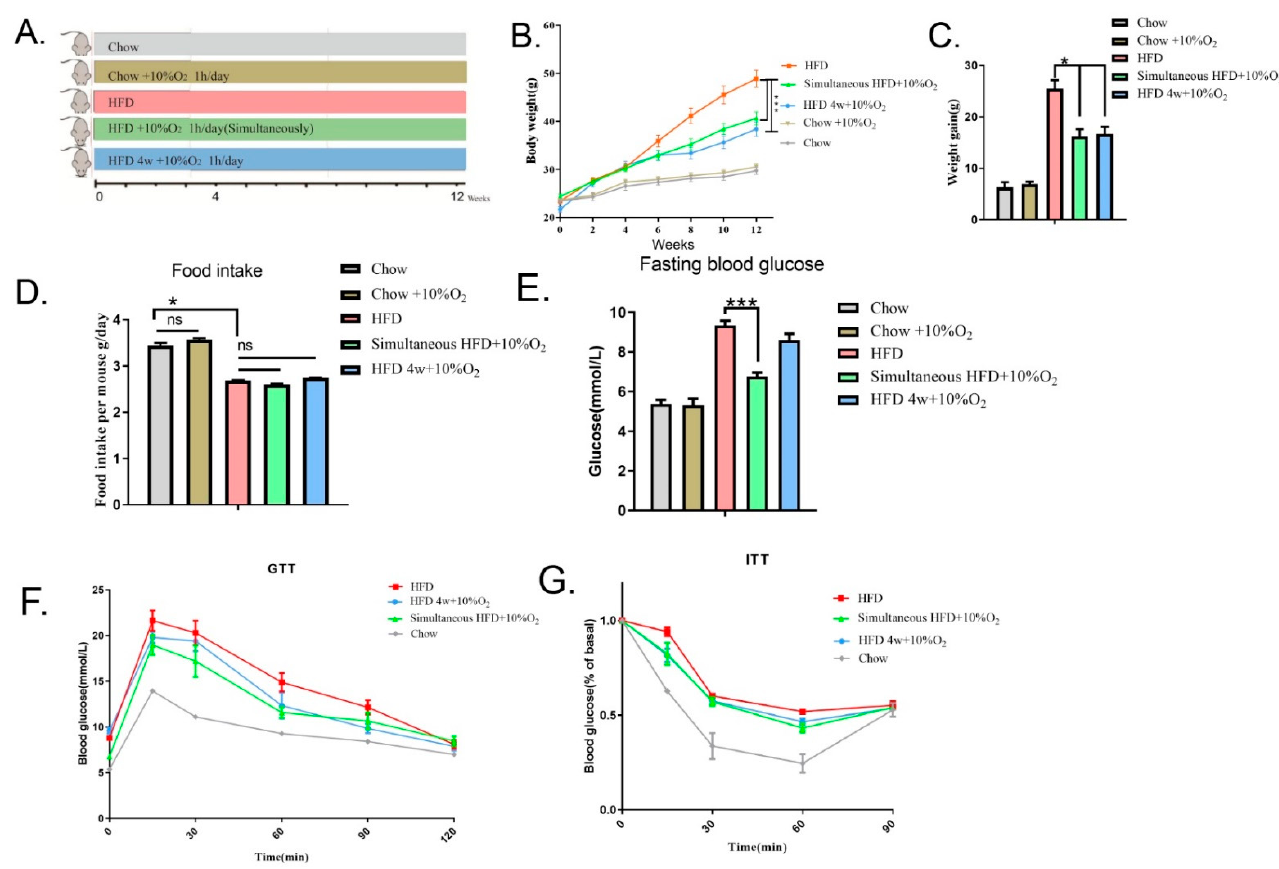
Figure 1. Chronic intermittent hypoxia reduces the bodyweight gain induced by HFD and improves insulin resistance. Experimental mice were exposed to ambient oxygen (normoxia) or 10% oxygen for one hour every day. ( A ) Scheme of grouping (8 mice per group): (1) chow diet and normoxia, (2) chow diet exposed to 10% oxygen, (3) HFD and normoxia, (4) HFD and 10% oxygen simultaneously, (5) HFD for 4 weeks and then 10% oxygen applied. ( B ) Body weight was measured every two weeks. Statistical analysis was performed by two-way ANOVA (mean ± SEM, n = 8). *** p < 0.005. ( C ) The value of bodyweight gain was obtained by subtracting bodyweight at the starting point from the endpoint (mean ± SEM). * p < 0.05. ( D ) Food intake (g/day/mouse) was recorded for one week and averages were presented. * p < 0.05, ns means not significant. ( E ) Fasting blood glucose levels wee measured. Significance was tested by Student’s t -test (mean ± SEM), *** p < 0.005. ( F , G ) Glucose tolerance test (GTT) and insulin tolerance test (ITT) were carried out. AUC for F: HFD, 1781; HFD 4 w + 10% O 2 , 1590; Simultaneous HFD + 10% O 2 , 1517; Chow, 1136. AUC for G: AUC: HFD, 59.05; HFD 4 w + 10% O 2 , 54.77; Simultaneous HFD + 10% O 2 , 53.85; Chow, 39.82. Significance was tested using two-way ANOVA (mean ± SEM). p < 0.05 (Group 3 vs. Group 4 and Group 3 vs. Group 5, respectively).